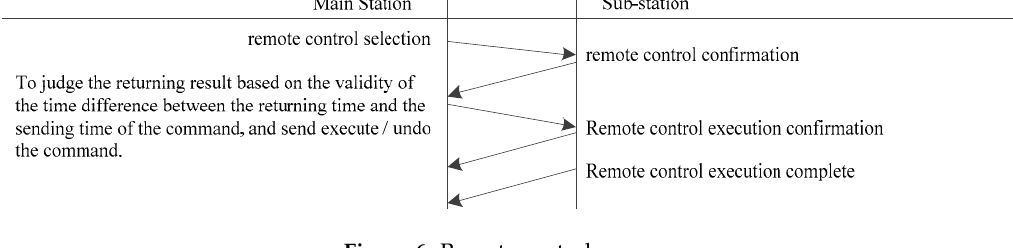
Figure 6. Remote control process.